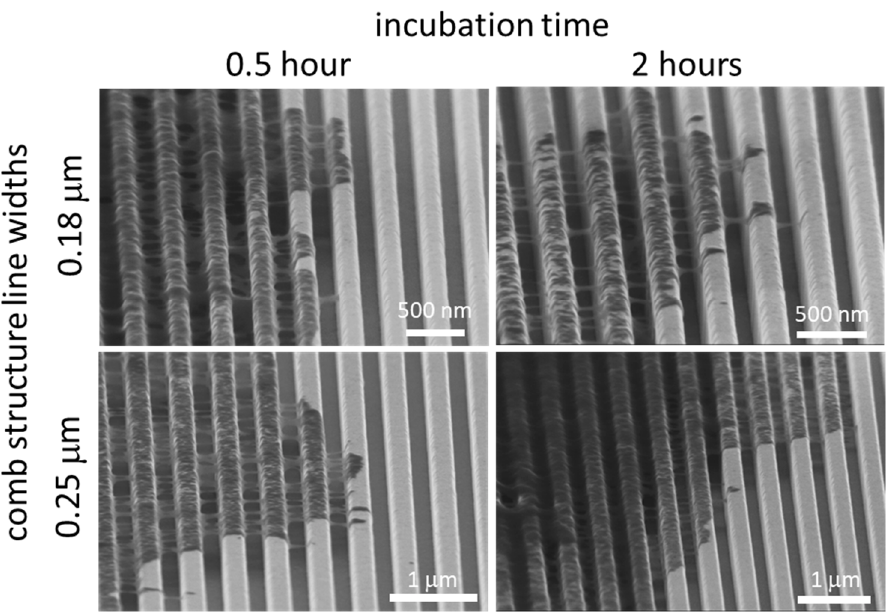
Figure 8. Typical SEM micrographs show Type 1 cell morphology was observed on 0.18 and 0.25 µ m comb structures after 0.5 and 2 h of incubation.